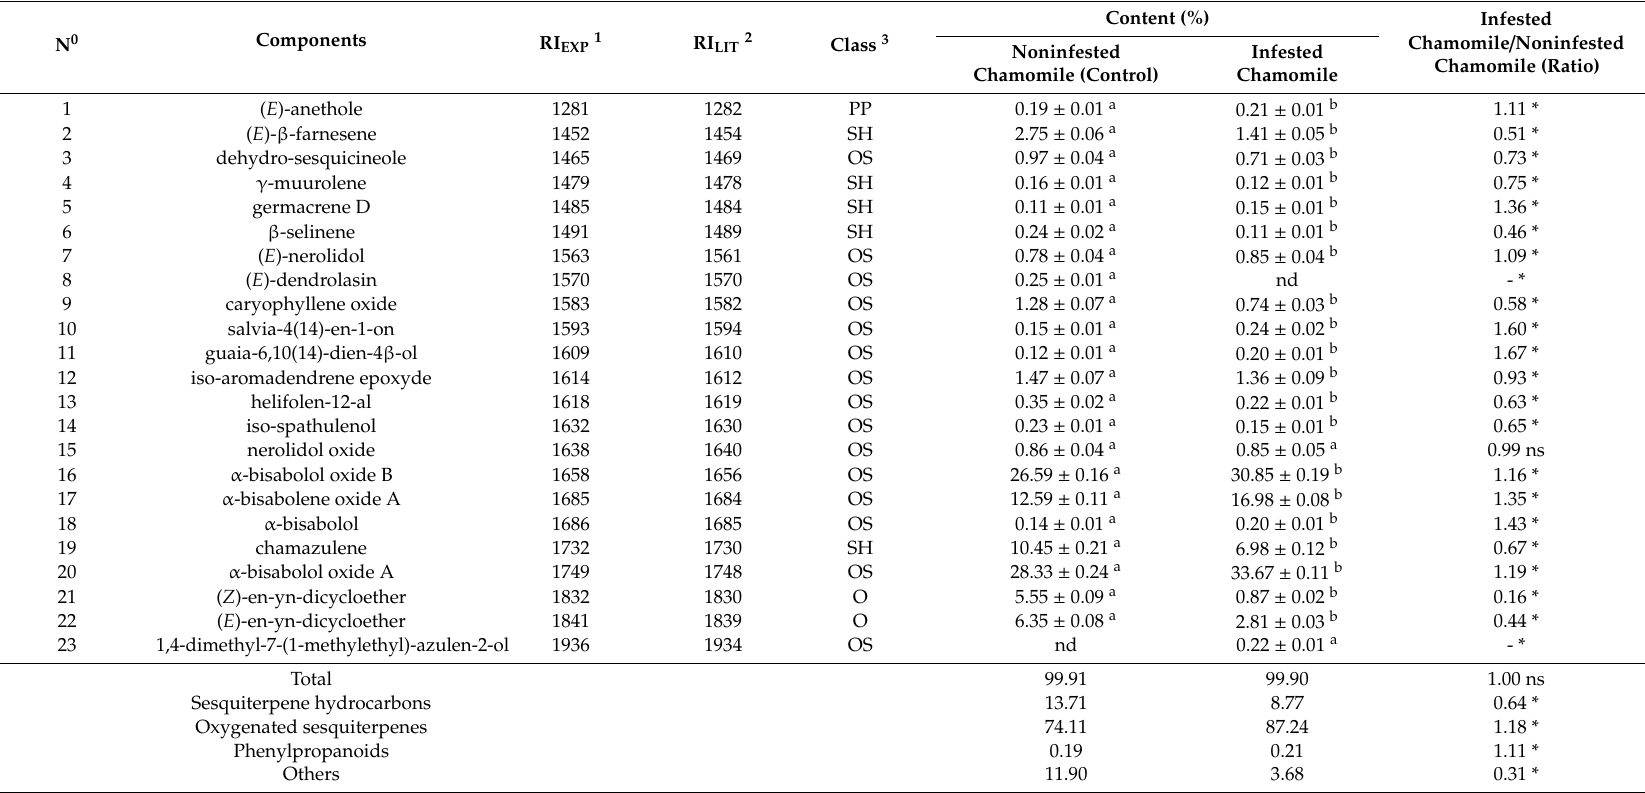
Table 4. Chemical compositions of chamomile essential oils (noninfested and infested